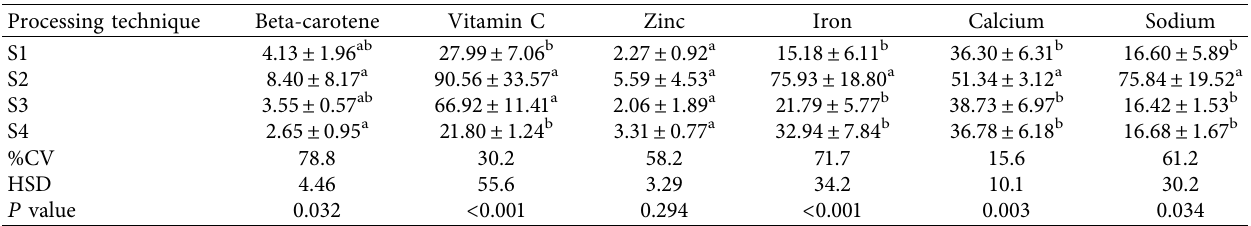
Table 2: Micronutrient composition of traditional preserved cowpea leaves (mg/100 g dry matter basis). Processing technique